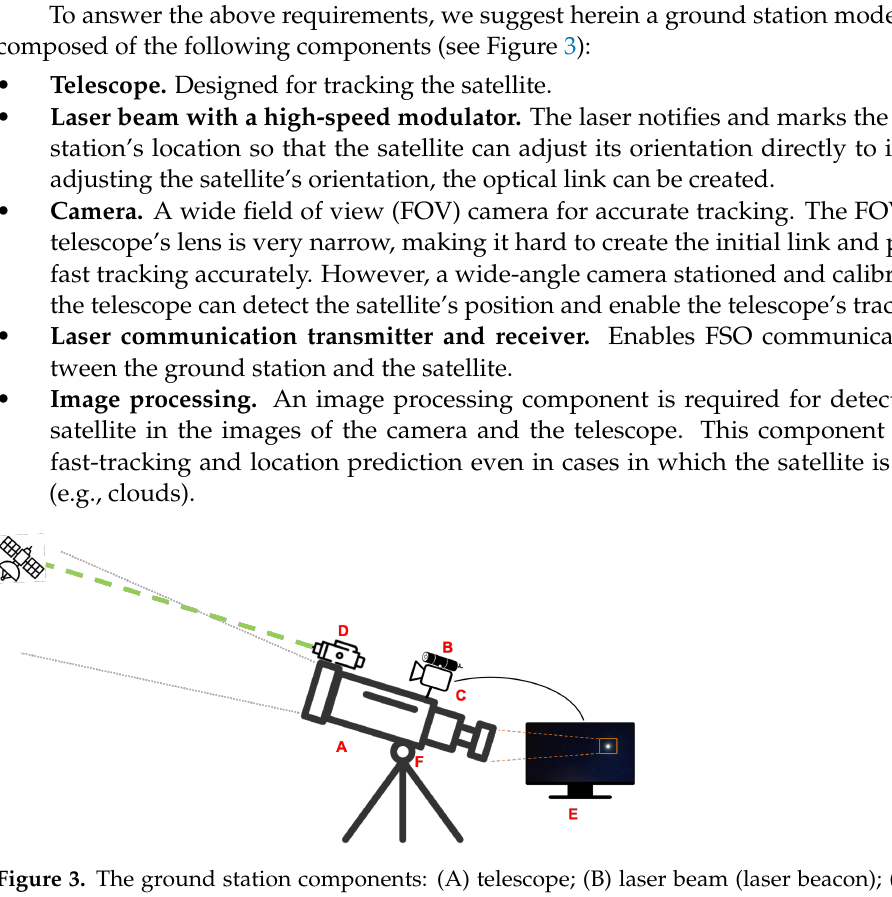
Figure 3. The ground station components: (A) telescope; (B) laser beam (laser beacon); (C) wide FOV camera; (D) FSO transmitter; (E) image processing component; and (F) gimbal mount with two degrees of freedom system (pitch and yaw) and aiming